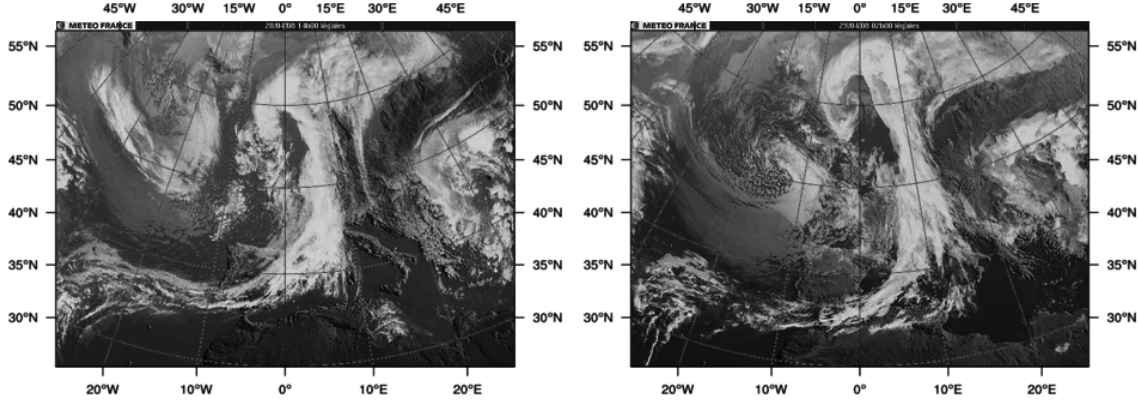
Figure 3. Evolution of a storm on western Europe: 28 April 2008 (left panel) and 29 April 2008 (right